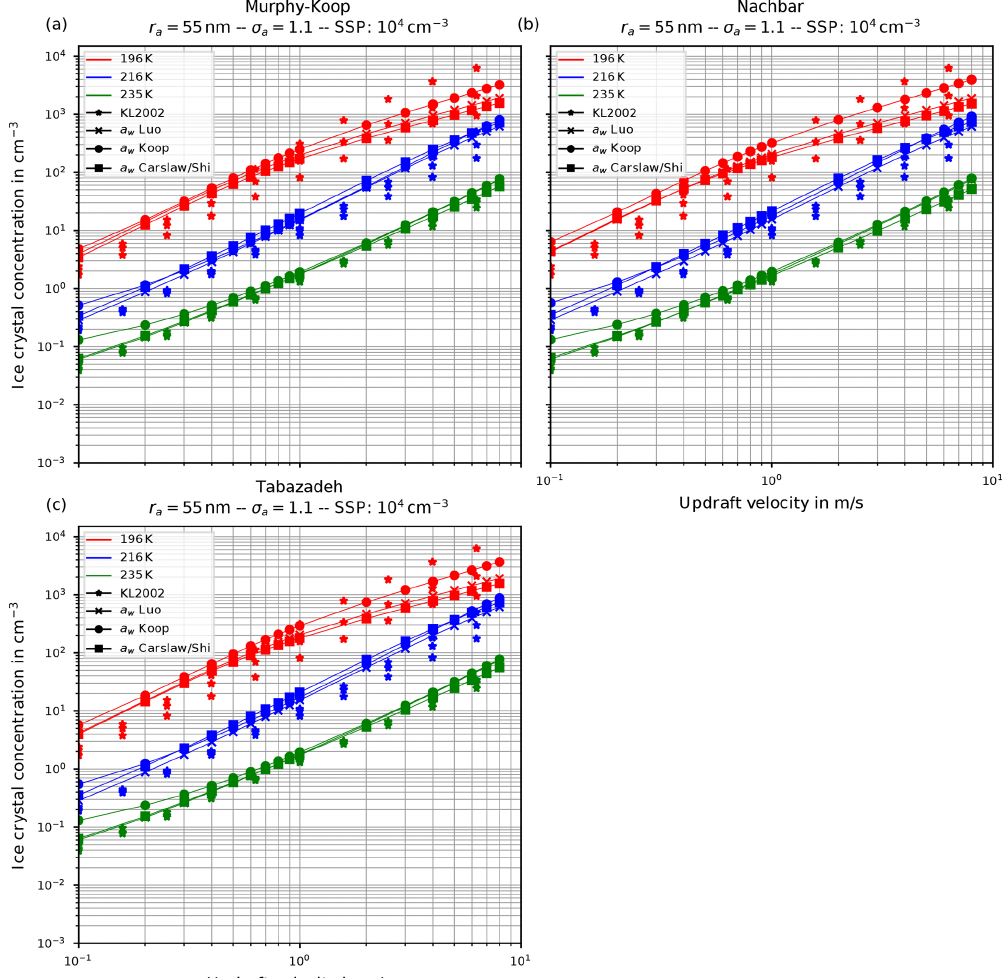
Figure D1. Same as in Fig. 6 but with a fixed time step of 5ms. Note that the range of vertical velocities is restricted to large vertical velocities to more clearly show the reduction of the model